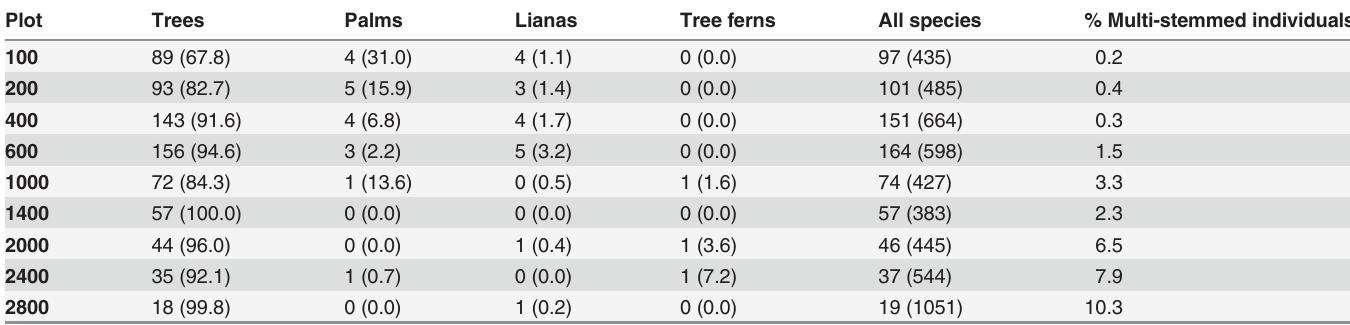
Number of species by life form groups and as percentage of individuals (in parenthsis) in 1-ha plots in old growth over a 2700-m elevational gradient in Braulio Carrillo National Park, Costa Rica. Data are from the last census at each site (December 2013-May 2014). Total number of individuals per site is given in brackets in the All Species Column.